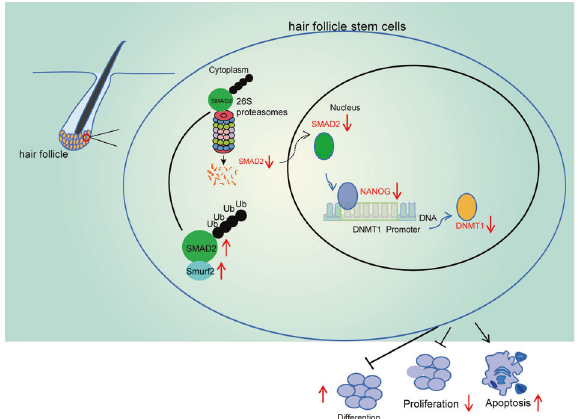
Fig. 7 A schematic map showing the involvement of Smurf2/ SMAD2/NANOG/DNMT1 axis in the HFSC differentiation, prolif- eration and apoptosis. Smurf2 degrades SMAD2 through ubiqui- tination, resulting in prevention of NANOG expression and DNMT1 transcriptional expression, thereby suppressing HFSC differentiation and apoptosis but inducing cell proliferation, ultimately inhibiting epidermal wound